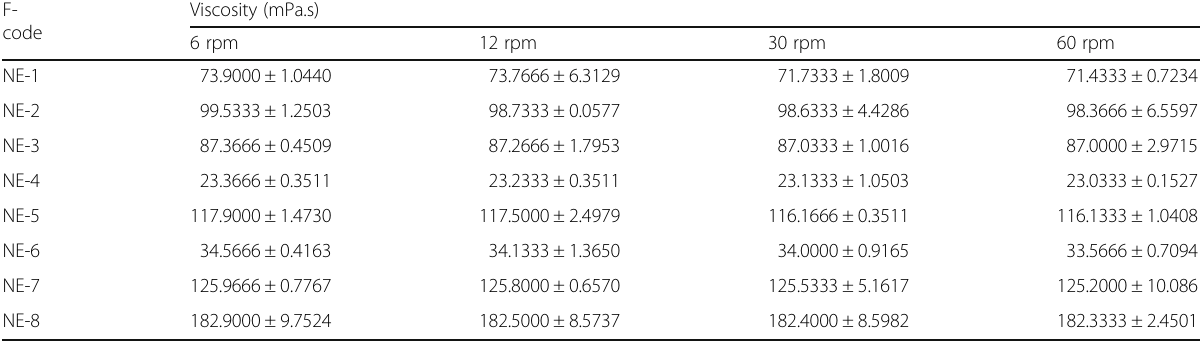
Table 4 Viscosity results of candesartan cilexetil